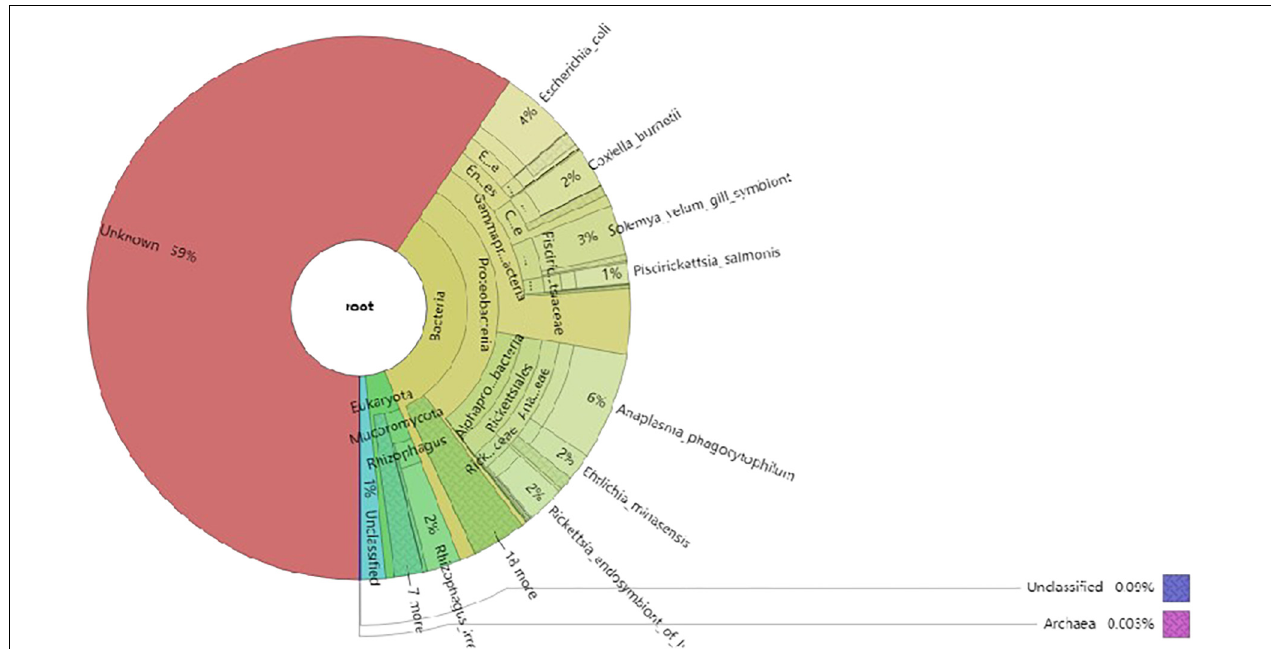
FIGURE 5 | The Krona diagram of taxonomy prediction. In the figure, circles represent different classification levels (kingdom, phylum, class, order, family, and genus) from inside to outside. The size of the sector represents the relative abundance of different